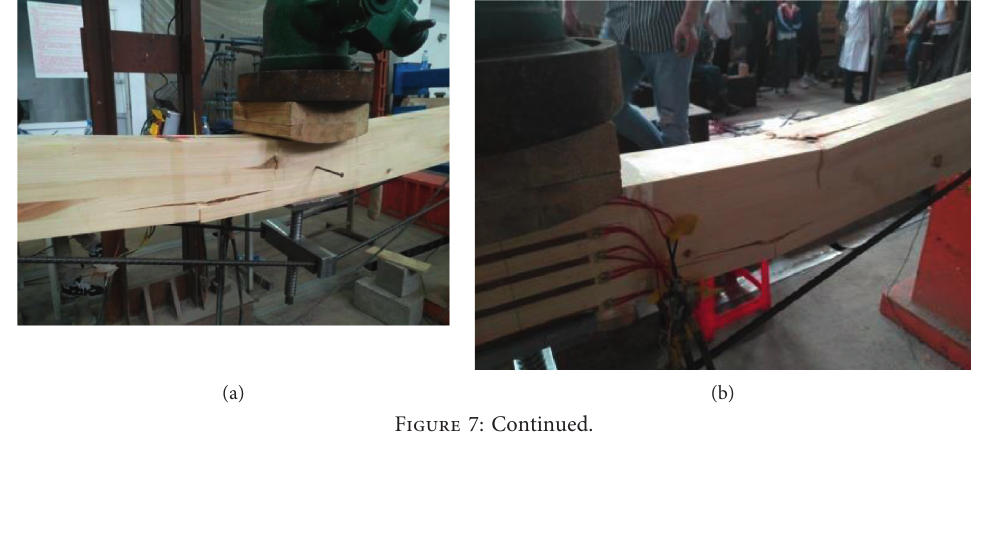
Figure 6: Wrinkling on top of the Glulam beam. (a) Wrinkling on top of the LA (c) Wrinkling on top of the LA 7(1) left